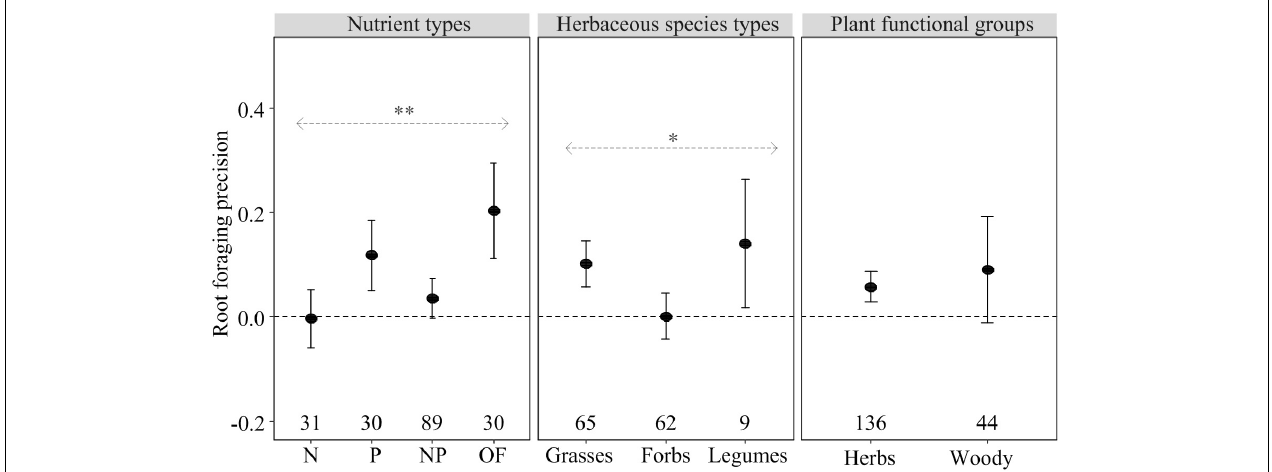
FIGURE 2 | The effect of the heterogeneous nutrient supply on root foraging precision (closed circles) as influenced by nutrient types (N, P, NP, or OF = organic fertilizer or organic matter), herbaceous species types (grasses, forbs, and legumes), and plant functional groups (herbs and woody) based on the first dataset. Error bars represent ± 95% confidence intervals. Effects are significant if confidence intervals (95% CI) for a given parameter do not overlap with zero. Mean effect sizes > 0 represent an increase in plant growth in nutritionally heterogeneous environment compared with homogeneous environment. The numbers under the CI bars represent the sample sizes. The asterisks denote significant difference among the categories. ∗ P ≤ 0.05; ∗∗ P <